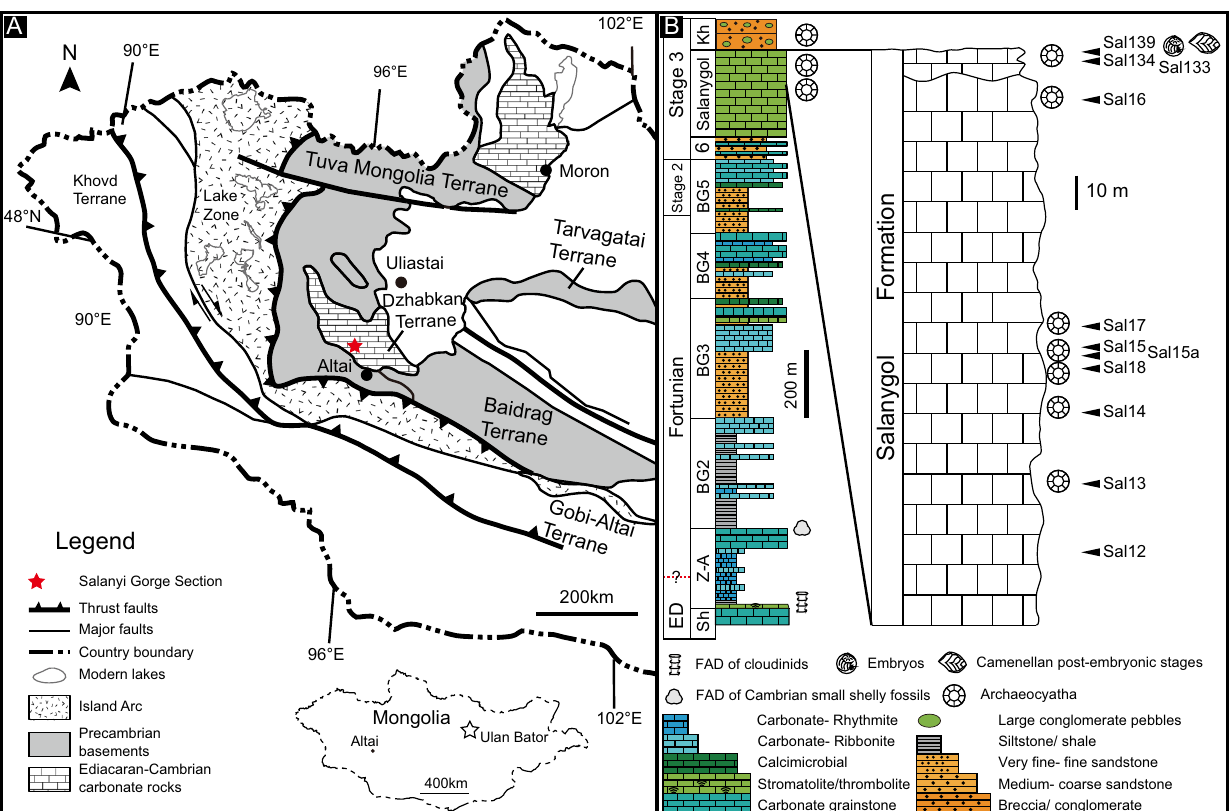
Fig. 1 Geographic and stratigraphic occurrence of new assemblage of embryonic and postembryonic developmental stages. A Locality of Salanyi Gol (Gobi-Altai Province) on Dzhabkan Terrain of Mongolia. B Stratigraphic column (modi fi ed from ref. 25 ) with the distribution of the embryonic and postembryonic developmental stages. ED Ediacaran, Sh Shurgat Formation, Z-A Zuun Arz Formation, BG Bayan Gol Formation (numbers refer to members according 25 ), Kh Khirekhan Formation, FAD fi rst appearance datum; sample numbers: Sal 139